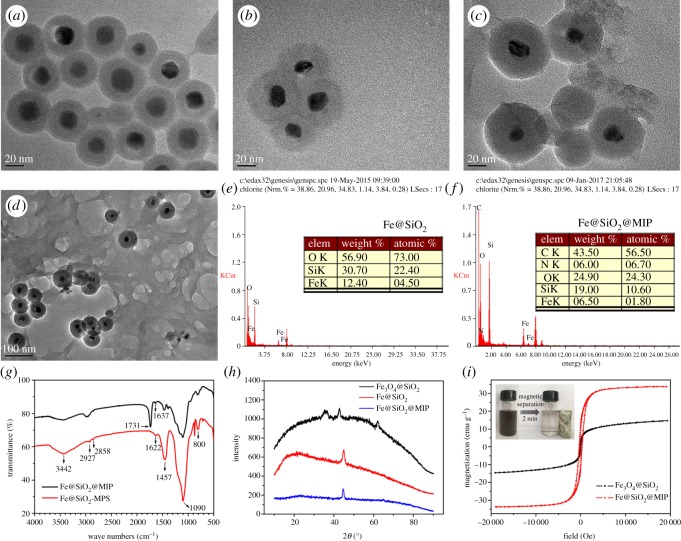
Characterization images. TEM images of (a) Fe3O4@SiO2; (b) Fe@SiO2; (c,d) Fe@SiO2@MIP; EDS spectrum of (e) Fe@SiO2 and (f) Fe@SiO2@MIP; FT-IR spectrum (g) of Fe@SiO2-MPS and Fe@SiO2@MIP; XRD spectrum (h) of Fe3O4@SiO2, Fe@SiO2 and Fe@SiO2@MIP; VSM hysteresis curve (i) of Fe@SiO2@MIP and the photograph of magnetic separation under magnet.